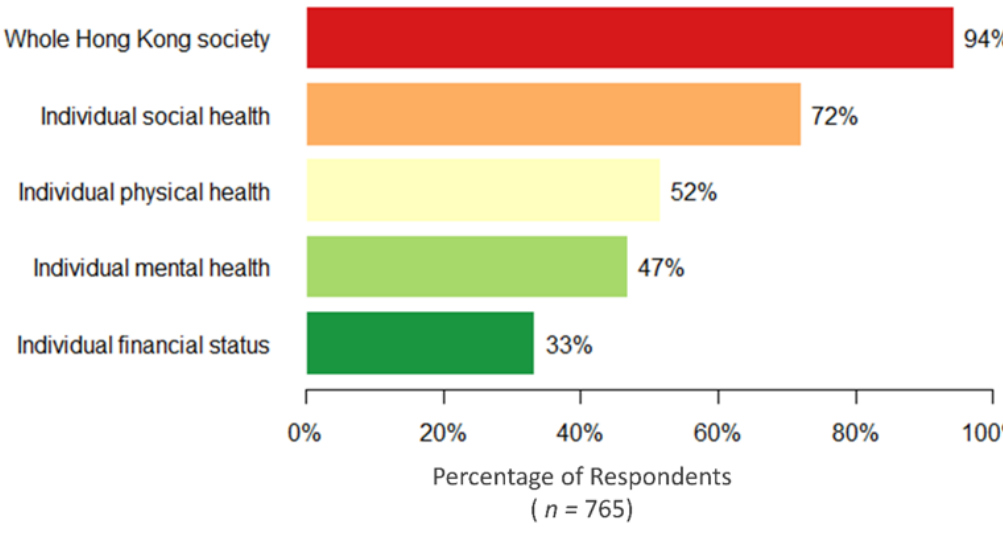
Figure 3. Self-reported large or very large impacts of COVID-19 on various dimensions.